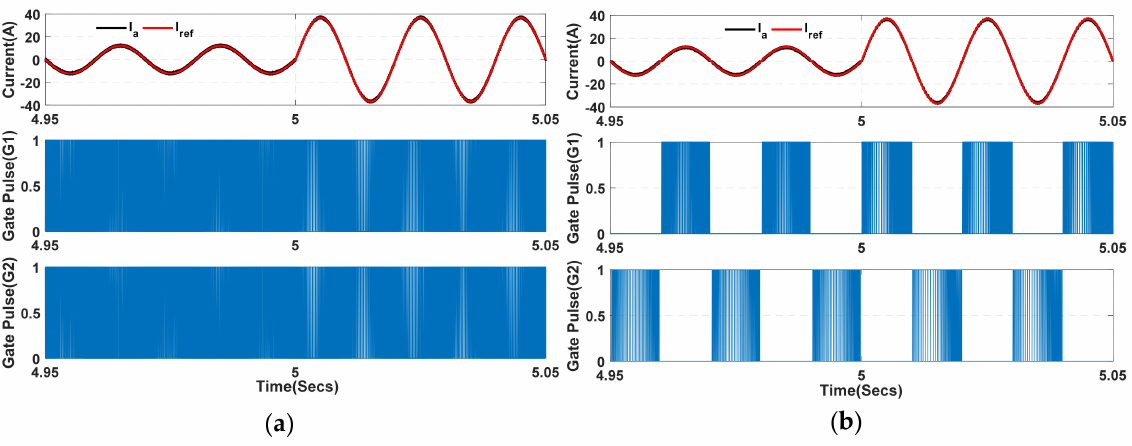
Figure 15. Simulation results showing I ref , I a , and switching pulses under load change for ( a ) IAOA- CHCC and ( b )